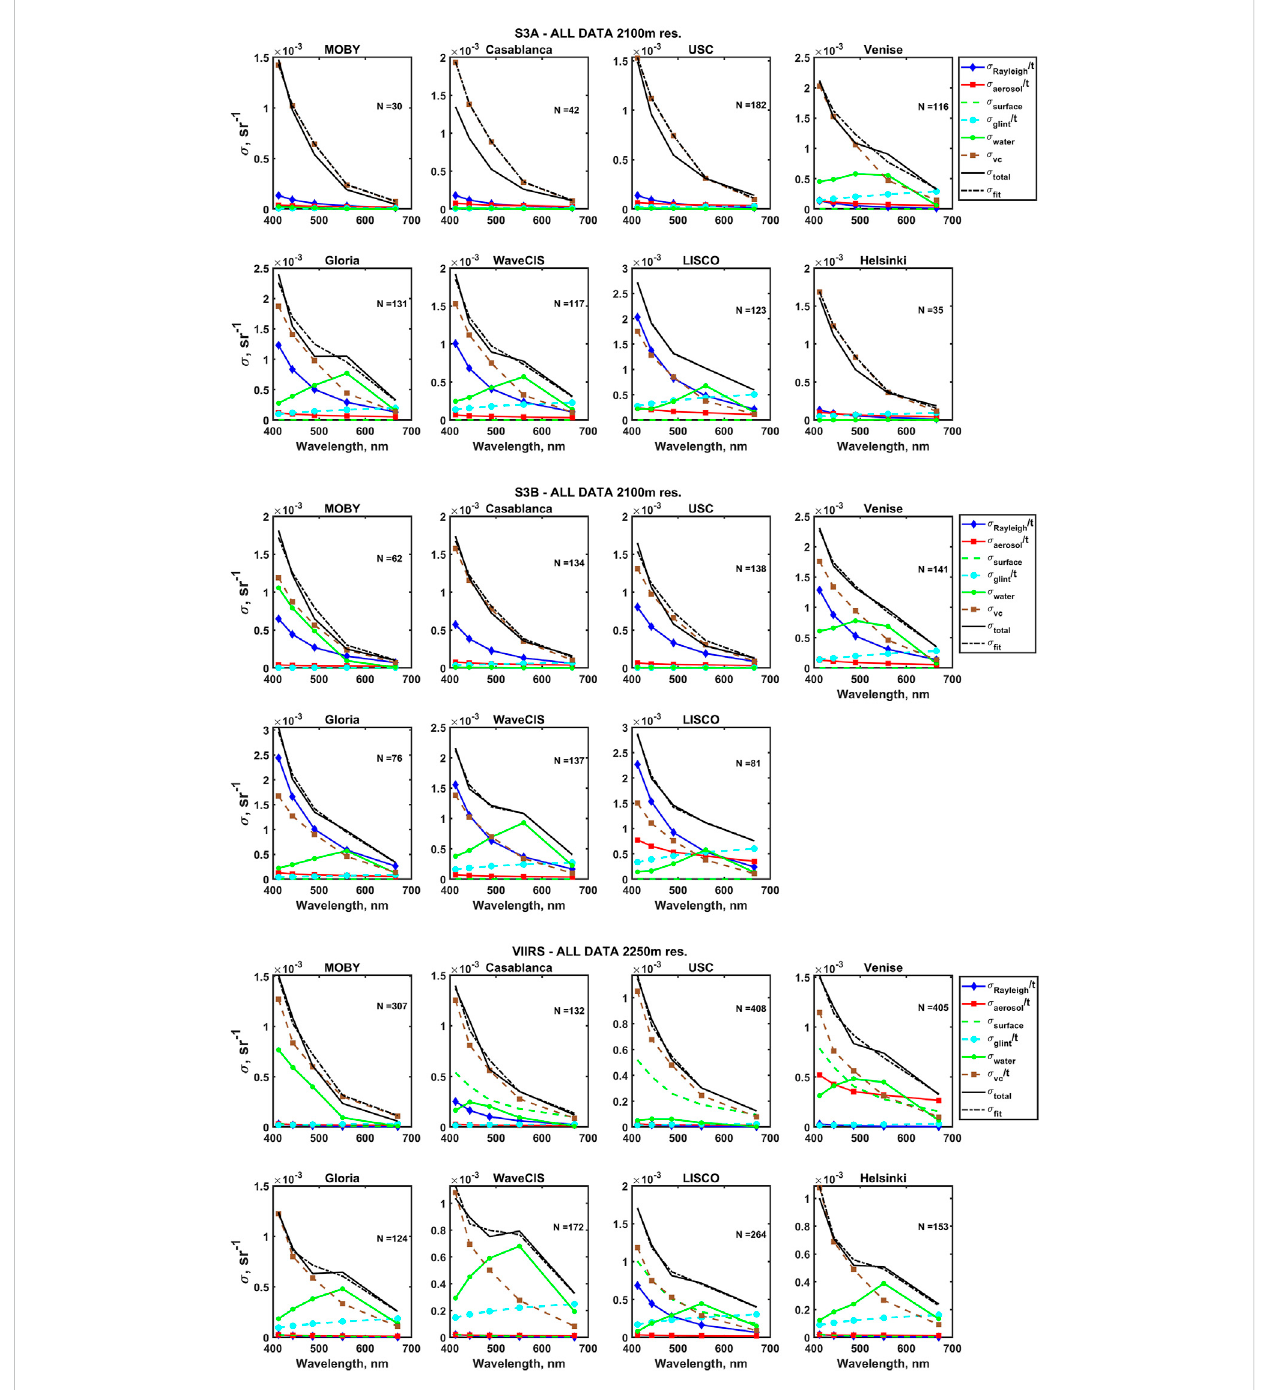
FIGURE 8 Results of fi tting for all areas of study for OLCI S3A, S3B and VIIRS with VC term included.